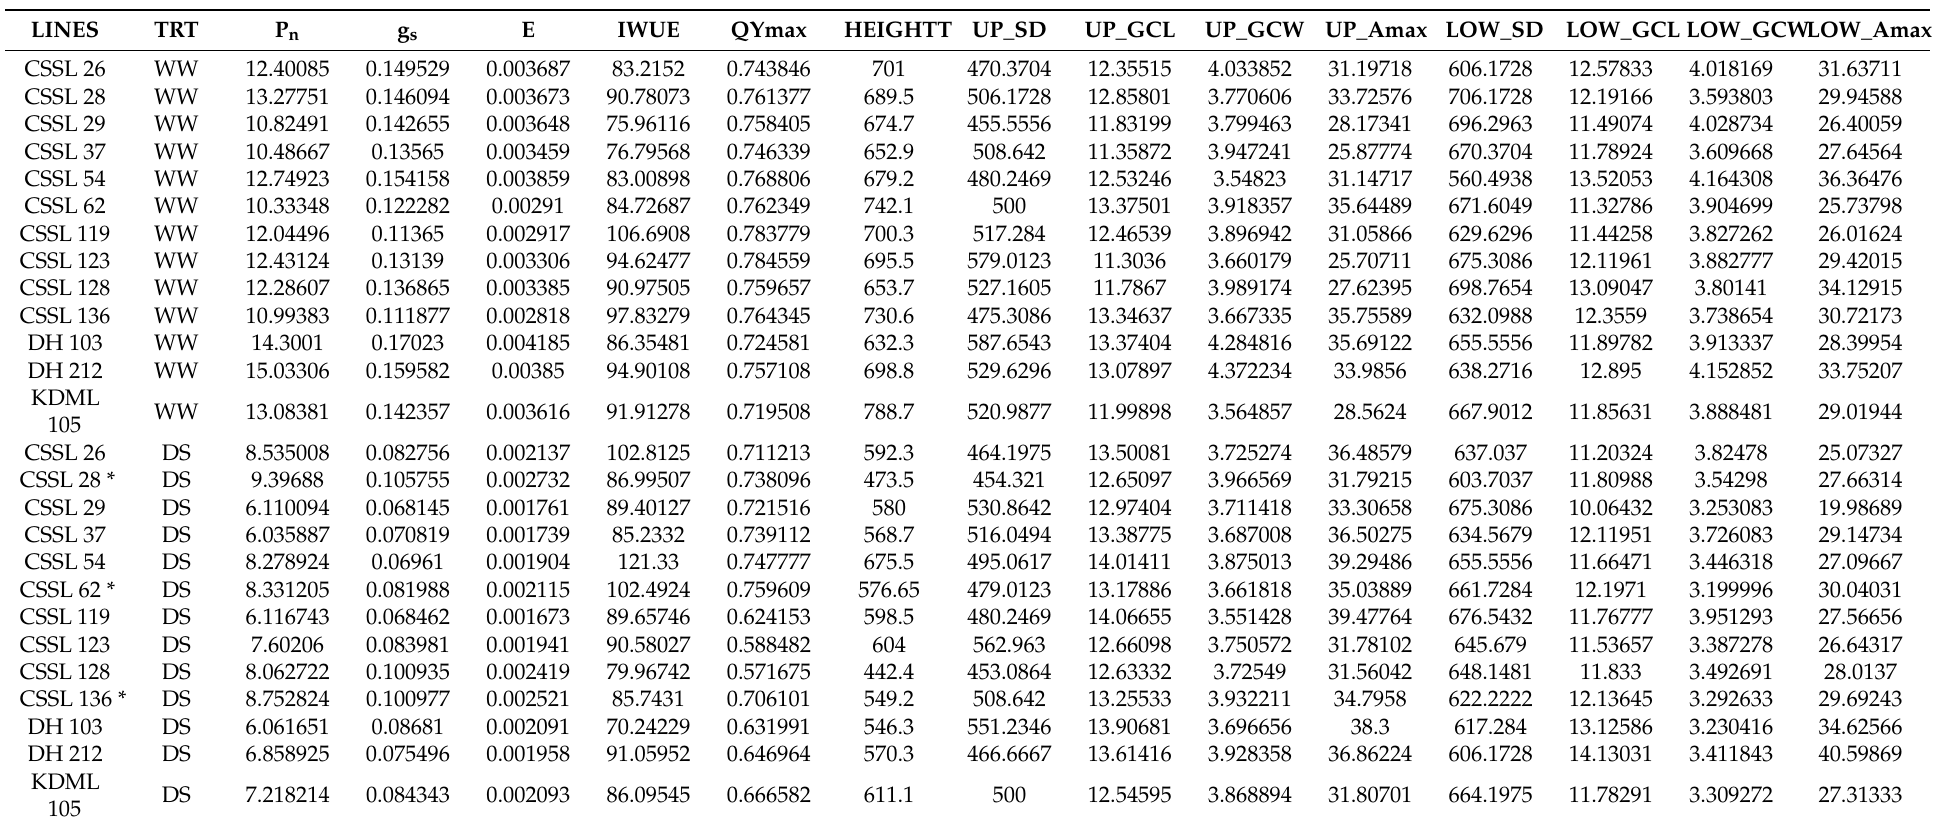
Table 2. Mean value of KDML105-CSSLs and parents for the physiological and stomata morphology traits under well-watered (WW) and drought stress (DS)